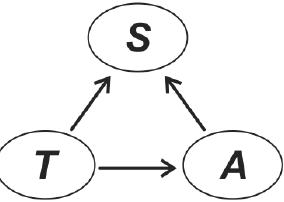
Figure 1. Directed Acyclic Graph (DAG) representing a hypothetical BN graphical model where the target variable soybean occurrence ( S ) is influenced by two context variables: terrain slope ( T ) and soil aptitude ( A ). Since soil formation processes are strongly influenced by terrain slope, T is also parent of A . Variables are represented by nodes and dependences are represented by arcs between pairwise